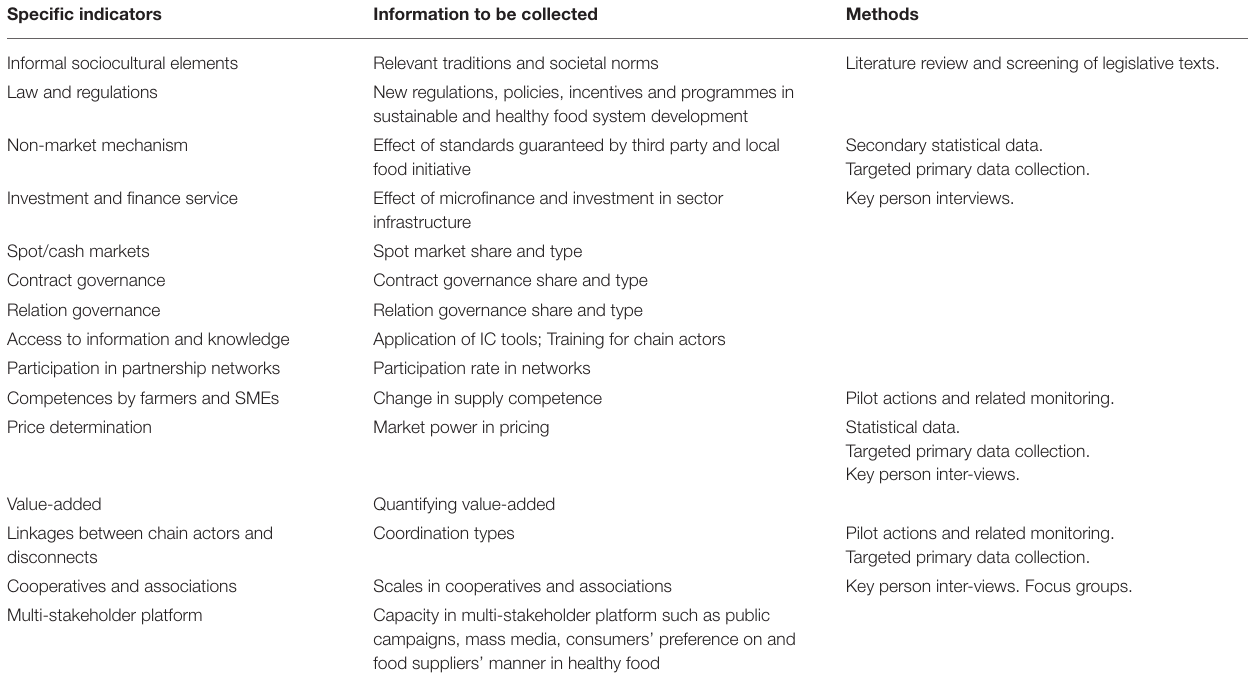
TABLE 4 | Information collection for each